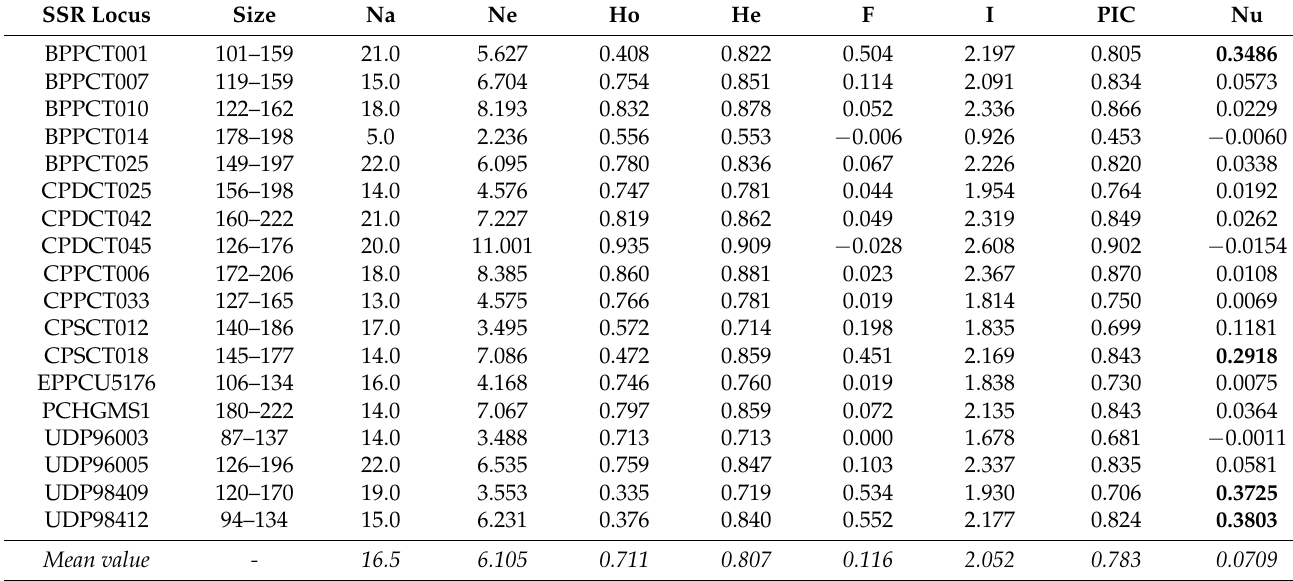
Table 1. Genetic diversity indices estimated for the considered SSR loci in the Apulian almond collection. For each locus, the allele size range (basepair, bp), the number of detected alleles (Na), the effective number of alleles (Ne), the observed (Ho) and expected (He) heterozygosity, the fixation index (F), Shannon’s index (I), the PIC value and the frequency of null alleles (Nu) are reported. The presence of null alleles is highlighted in bold.